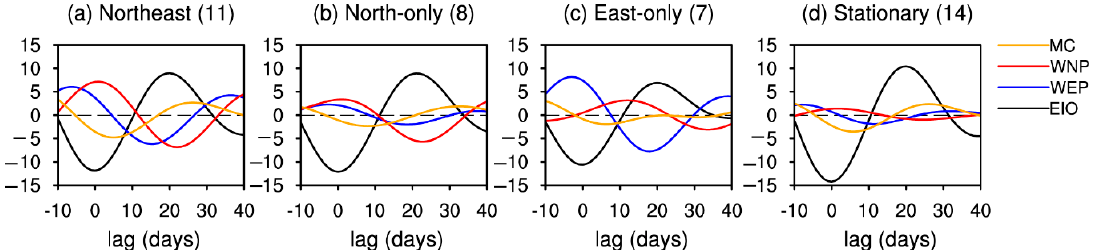
Figure 2. Regionally averaged OLR evolutions related to EIO ISO for the four modes. Lagged regression of OLR anomalies (W m -2 ) averaged over the EIO (black line), WNP (red line), WEP (blue line), and the Maritime Continent (MC) (yellow line) onto the EIO OLR anomaly for ( a ) northeast mode, ( b ) north-only mode, ( c ) east-only mode, and ( d ) stationary mode years. The number inside the brackets above each panel denotes the number of years of the mode during the 40-year study period. A 30–90-day bandpass-filter is applied to the OLR before the regression.